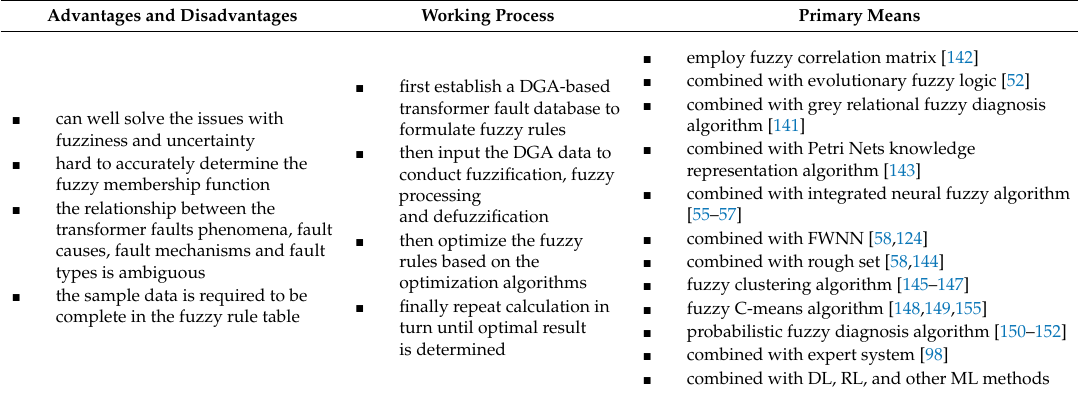
Table 7. A summary for the application of fuzzy theory in DGA based transformer fault diagnosis. Advantages and